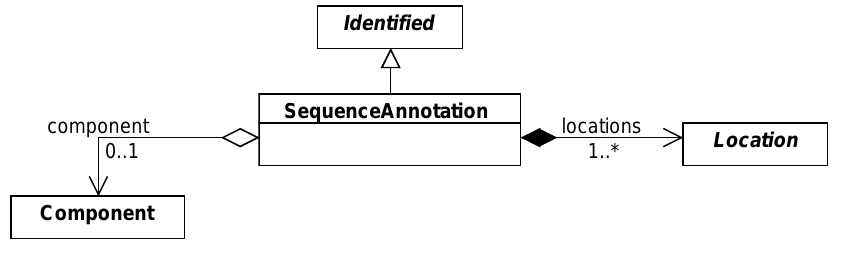
Figure 11: Diagram of the SequenceAnnotation class and its associated